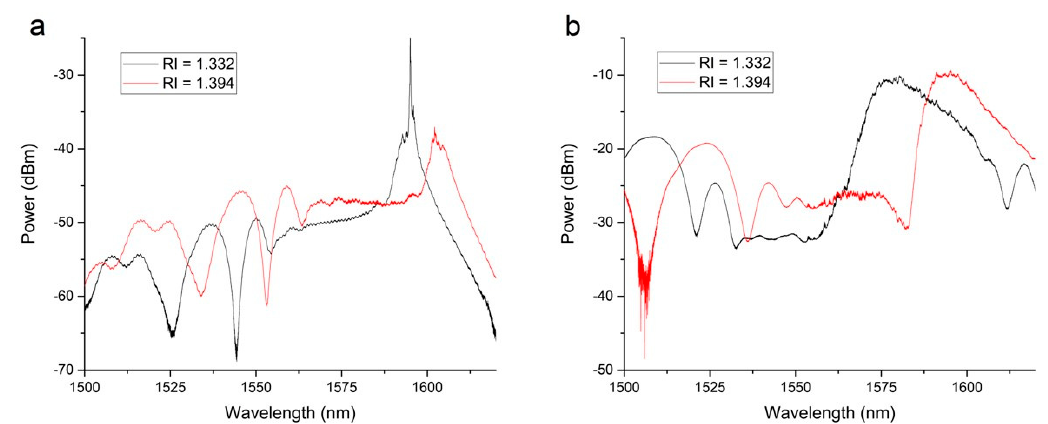
Figure 2. Spectra of SMS sensors exposed to external media with different values of refractive indexes. Results show uncoated sensors ( a ) and sensors coated with − 150 V self-bias diamond-like carbon film ( b ).